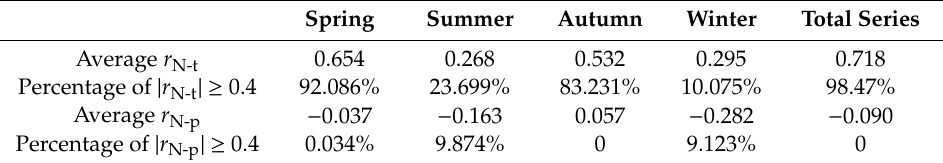
Figure 7. Partial correlation coefficient of NDVI–precipitation in four seasons: ( a ) spring; ( b ) summer; ( c ) autumn; and ( d ) winter. Table 1. Average and percentage results of four seasons and total series.